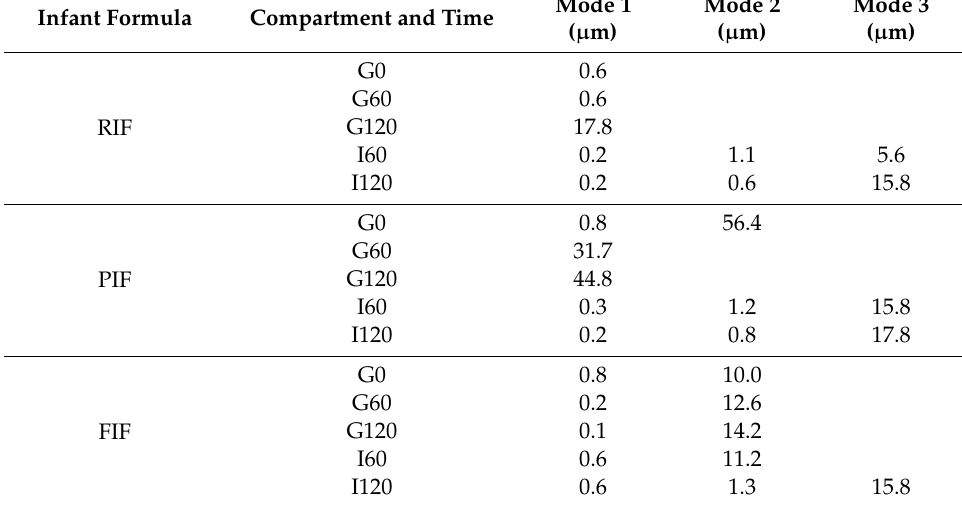
Table 3. Mode diameters ( µ m) of RIF (reference infant formula), PIF (pea infant formula), and FIF (faba bean IF) samples in gastric (G) and intestinal (I) compartments over in vitro dynamic